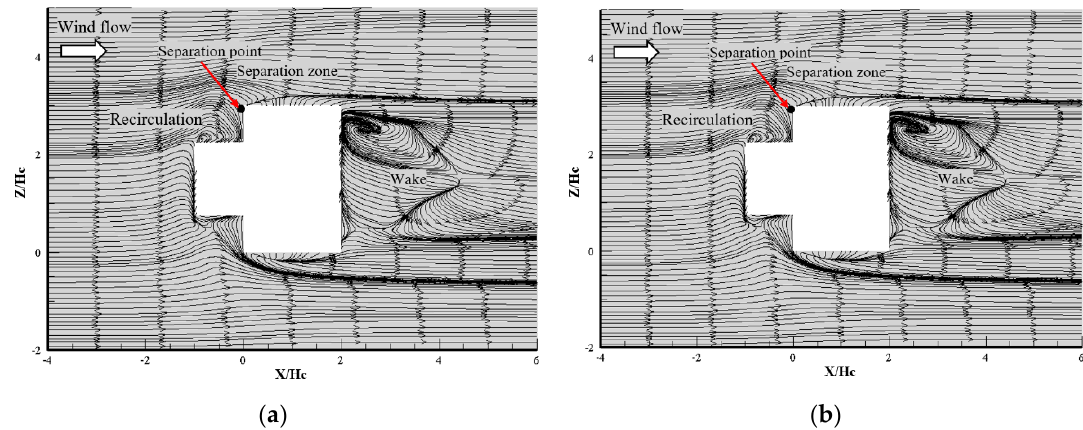
Figure 15. The streamlines plan view with kitchen at the ( a ) center and ( b ) edge.